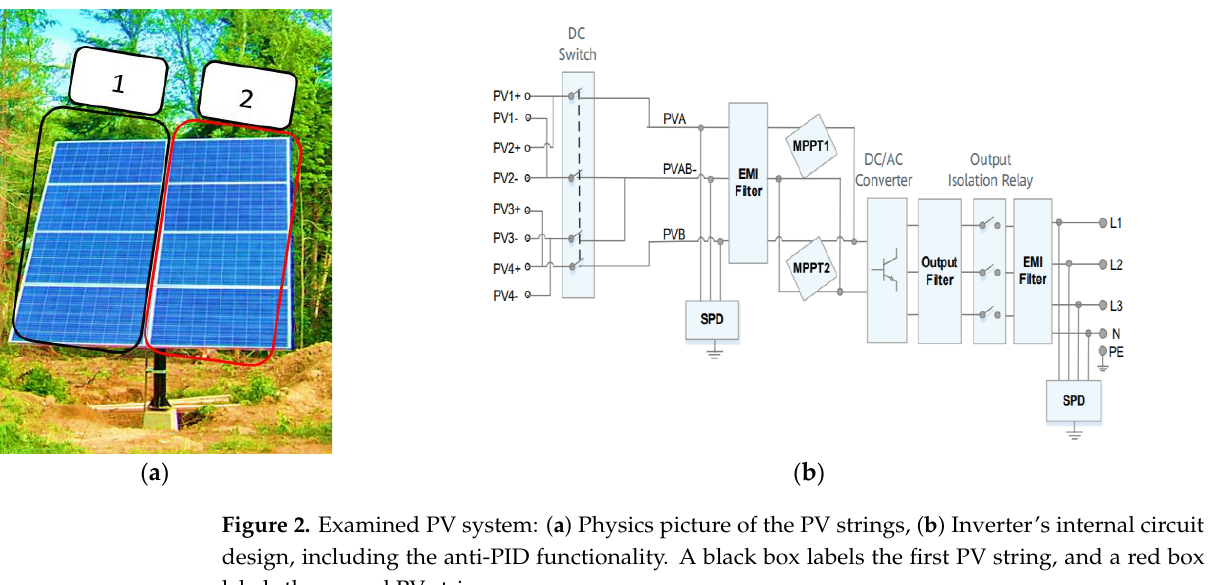
Table 1. Main electrical parameters of the examined PV modules at STC conditions.